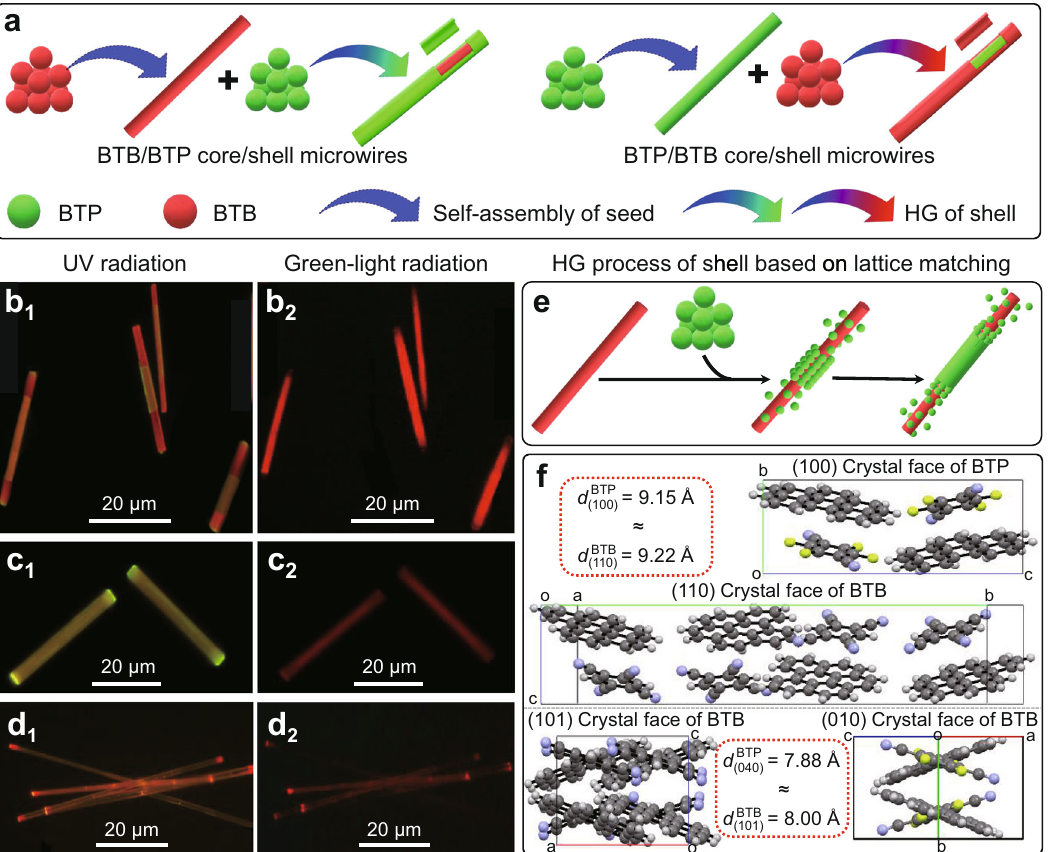
Fig. 2 Core/shell microwires with component interchange. a Schematic representation of the horizontal epitaxial-growth approach for the organic core/ shell microwires with component interchange. FM images of b BTB microwires with partly covering by BTP, c BTP/BTB microwires, and d BTP/BTB core/ shell microwires with the scale bars of 20 μ m. The microwires in ( b 1 , c 1 , and d 1 ) were excited with UV light ( λ = 330 – 380 nm) from a mercury lamp. Although the microwires in ( b 2 , c 2 , and d 2 ) were excited with green light ( λ = 500 – 550nm) from a mercury lamp. e Schematic representation of horizontal epitaxial-growth process for the formation of BTB/BTP core/shell microwires. f Molecular arrangement and orientation at the junction of core/shell